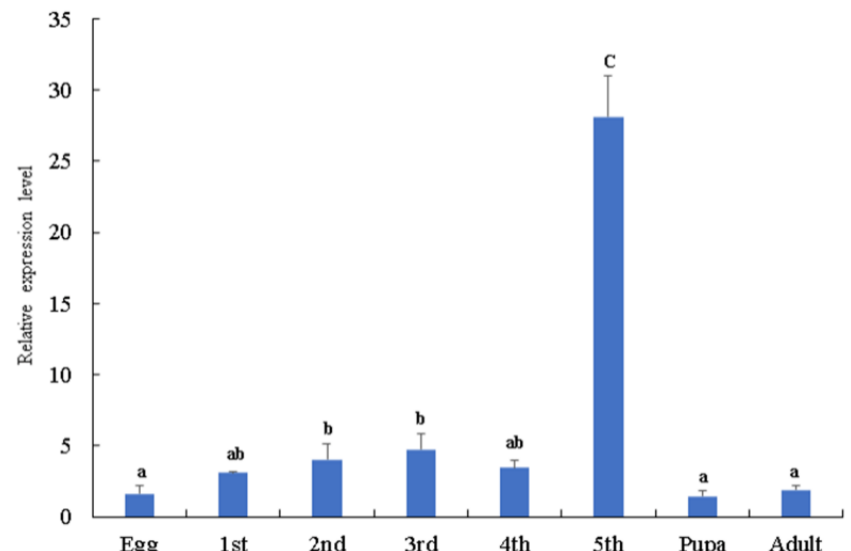
Figure 2. The expression pattern of Bmserpin2 in di ff erent developmental stages using whole insect body. Analysis of mRNA levels of Bmserpin2 in di ff erent developmental stages using qRT-PCR. The Bmserpin2 transcript level in the egg was used as the calibrator. Data were normalised with Bombyx mori GAPDH. Error bars show mean ± SD ( n = 3). Significant di ff erence is indicated with di ff erent letters (one-way ANOVA followed by Tukey’s test, p < 0.05).